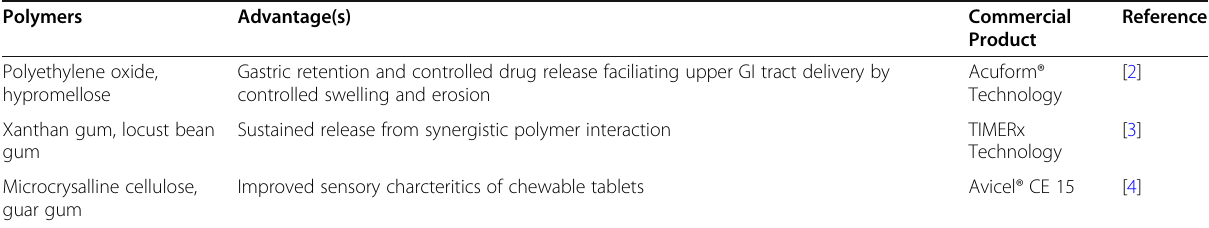
Table 2 Polymer blends in tablet technology platforms and excipients